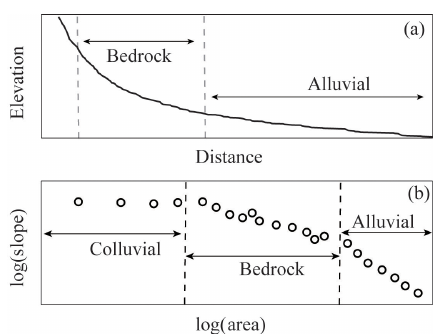
Figure 1. Schematic of a steady-state river profile consisting of col- luvial, bedrock and alluvial channels, revised from Fig. 7a and b in Snyder et al. (2000). (a) Stream profile. (b) Log-transformed slope– area plot.